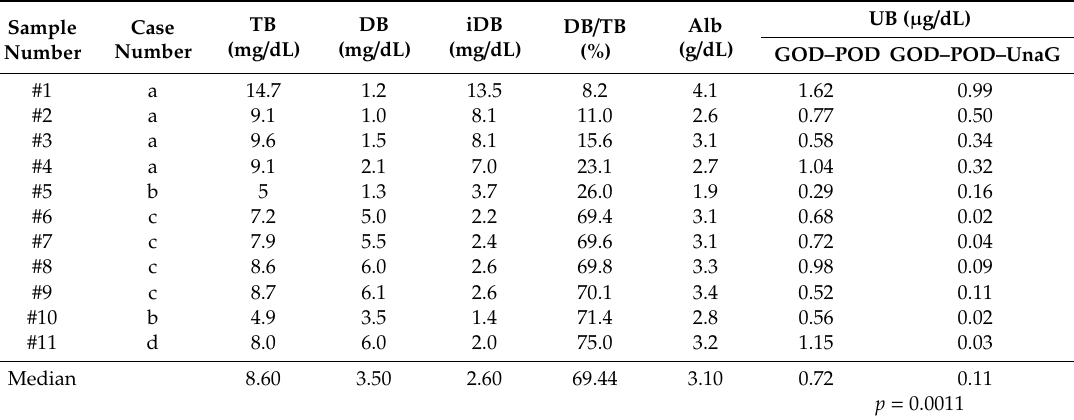
Table 1. Characteristics of high DB / TB ratio